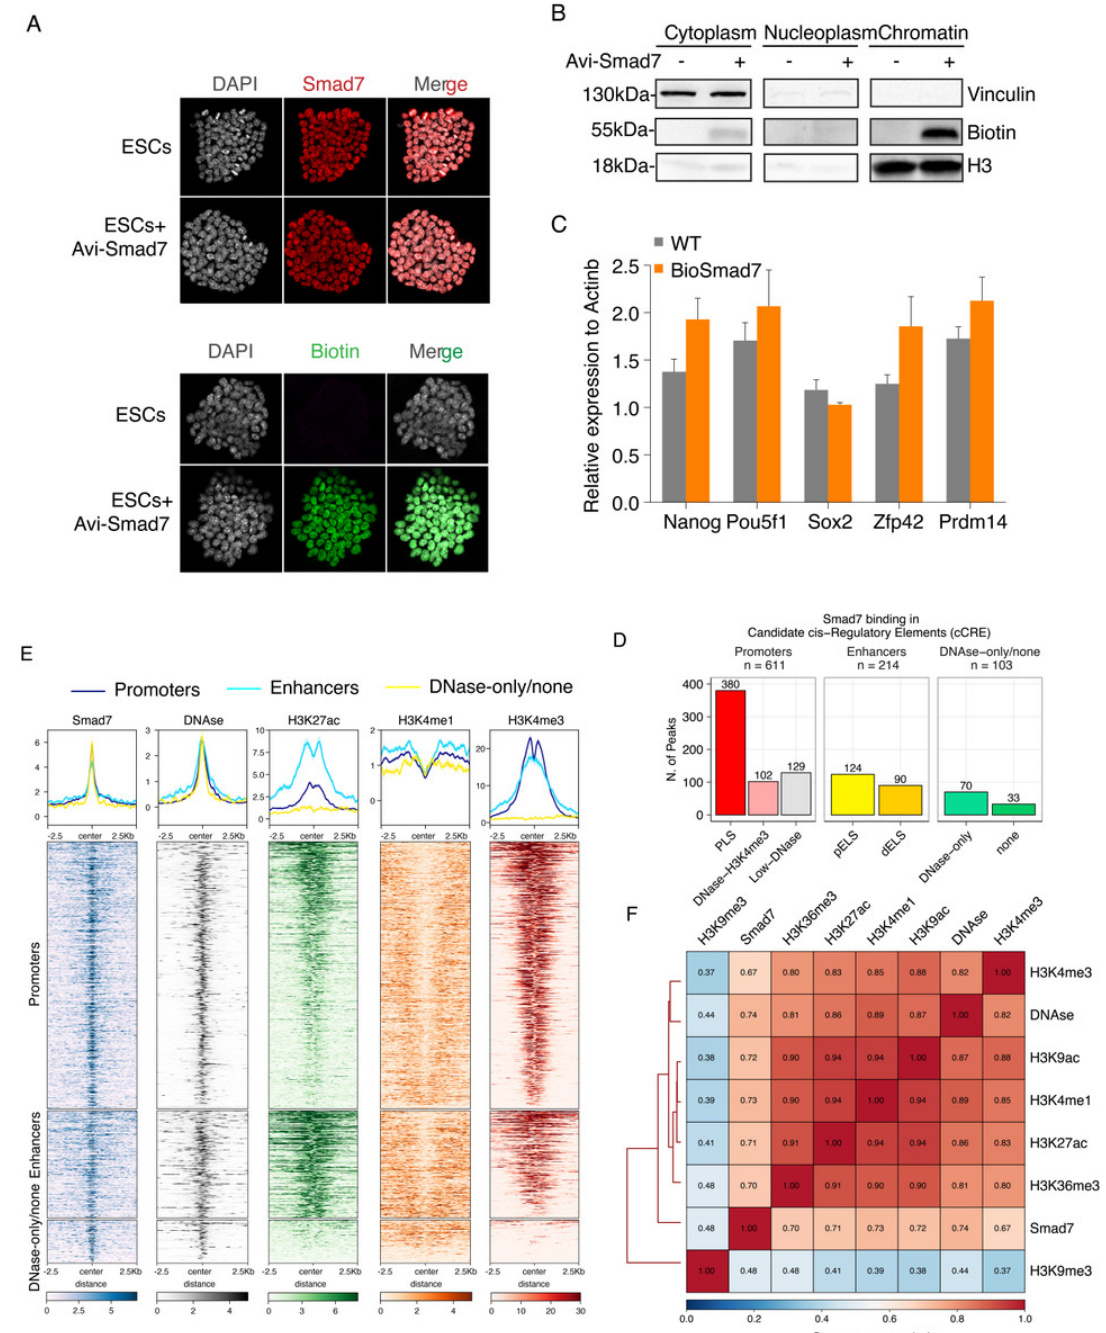
Figure 2. Genome-wide identification and characterization of Smad7 binding sites in ESCs. ( A ) Immunofluorescence assay of Smad7 (up) and Biotin (down) in the ESCs transfected with Avi-Smad7 compared with the un-transfected control. Nuclei were stained with DAPI. ( B ) Western blot analysis using an anti-Biotin antibody compared the expression of exogenous (bio-tagged) Smad7 in three cells’ fractions. BirA cells and Avi-Smad7 transfected cells were used in this experiment. Vinculin was used as a cytoplasm marker, and H3 was used as a chromatin marker. ( C ) RT-qPCR analysis of Nanog , Pou5f1 , Sox2 , Zfp42 , and Prdm14 in Avi-Smad7 transfected cells (BioSmad7) in comparison to WT ESCs. The expression level was normalized to Actinb . Data are shown as mean ± SEM; n = 3. ( D ) A bar graph presenting the distribution of Smad7